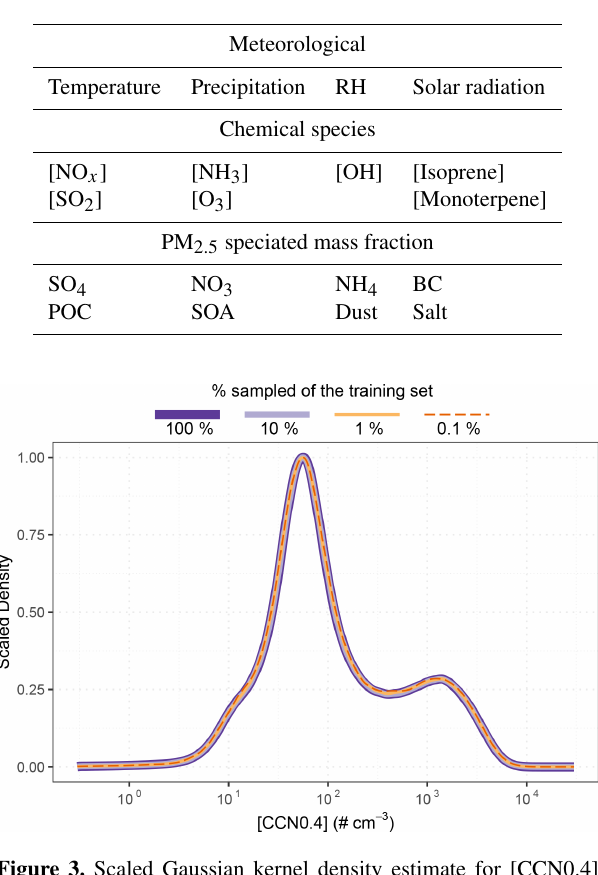
Table 2. Selected atmospheric state and composition variables as RFRM predictors for [CCN0.4].